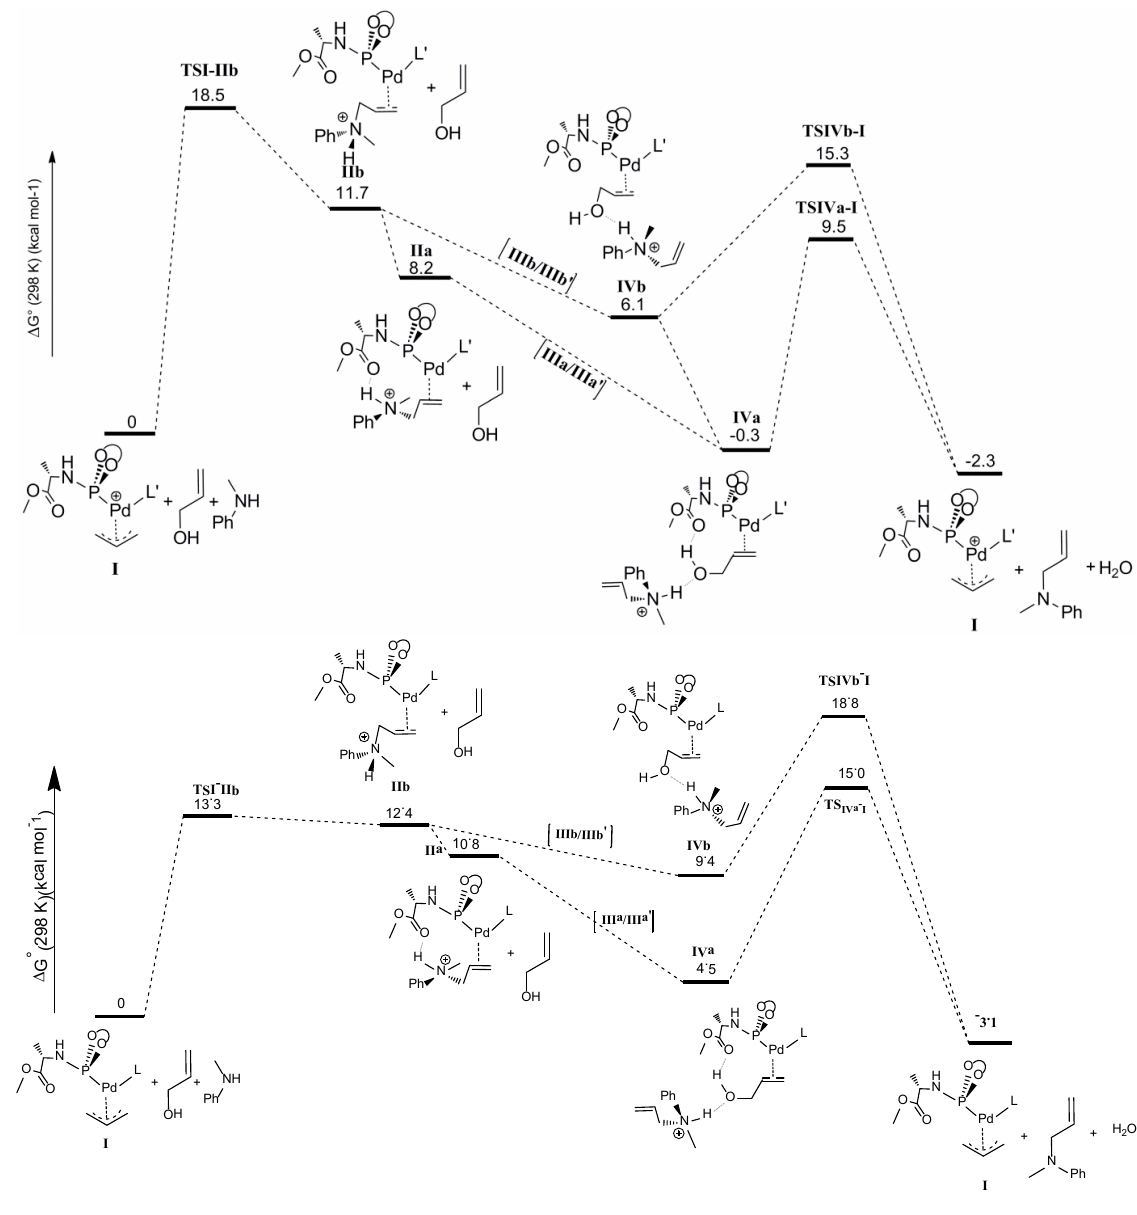
Scheme 8. Calculated catalytic pathway of the complete cycle. Top : Free energies without cosmo corrections; Bottom : Free energies with cosmo corrections ( ε = 2.38;